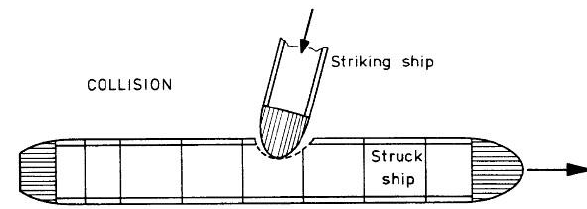
Figure 4: Side collision by upper view [14].